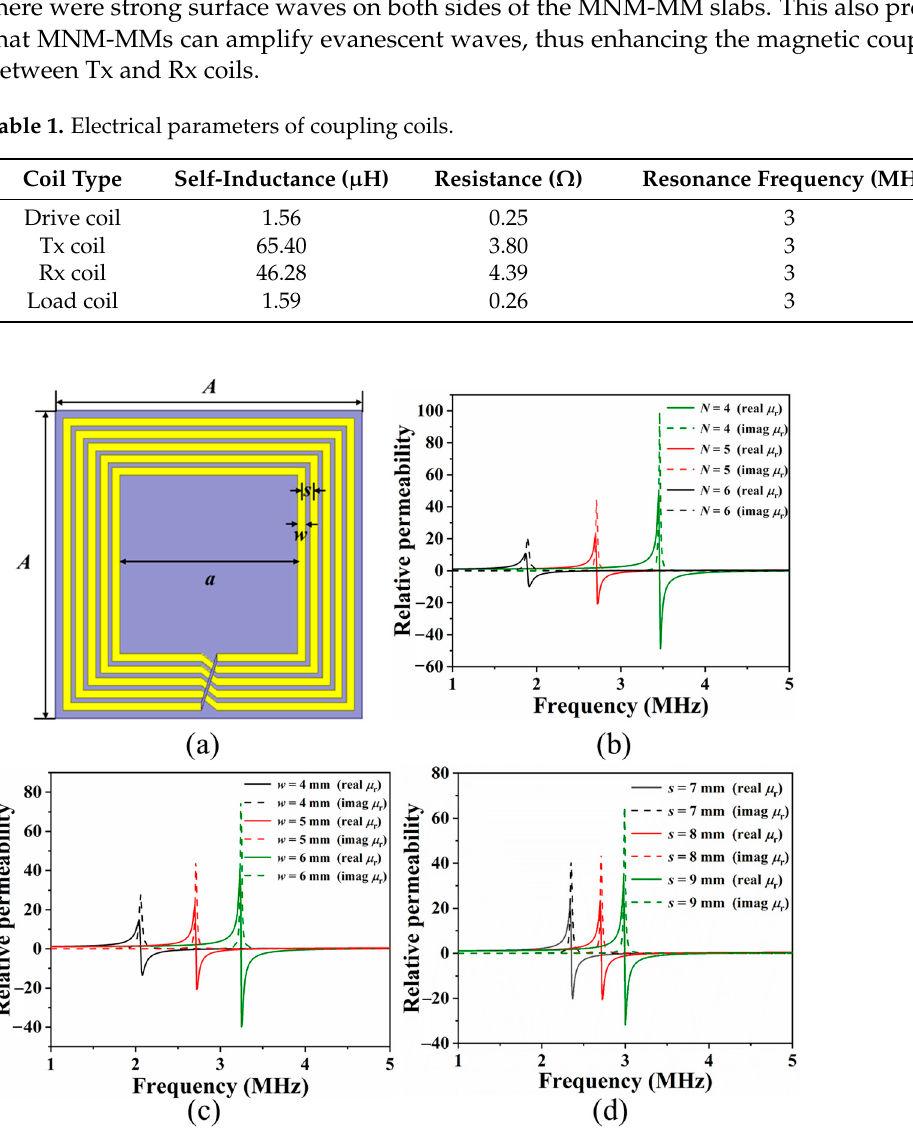
517 Figure 6. Comparison diagram of magnetic field intensity distribution for a system with one met- amaterial slab, a system with two metamaterial slabs, and a system without metamaterial slabs. 3. Experimental Results The experimental setup of a four-coil WPT system with MM slabs is shown in Figure 7, where they are all placed coaxially. The load coil was connected with a resistance of 10